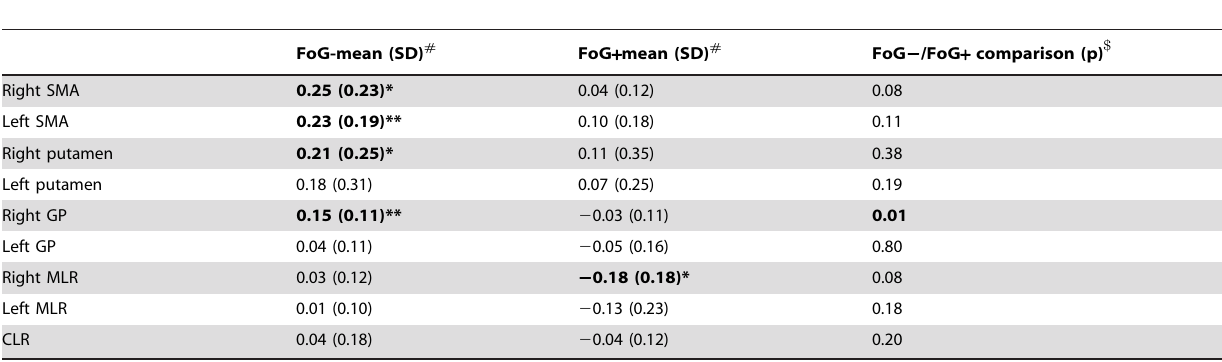
Table 4. Mean (SD) beta weights and p-values for imagined walking in FoG 2 and FoG + , normalized to